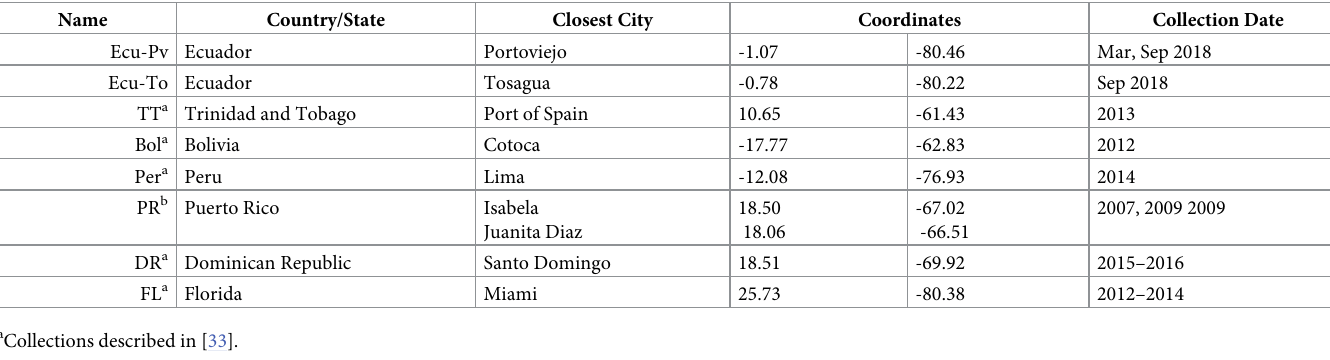
Table 1. Source information for fall armyworm